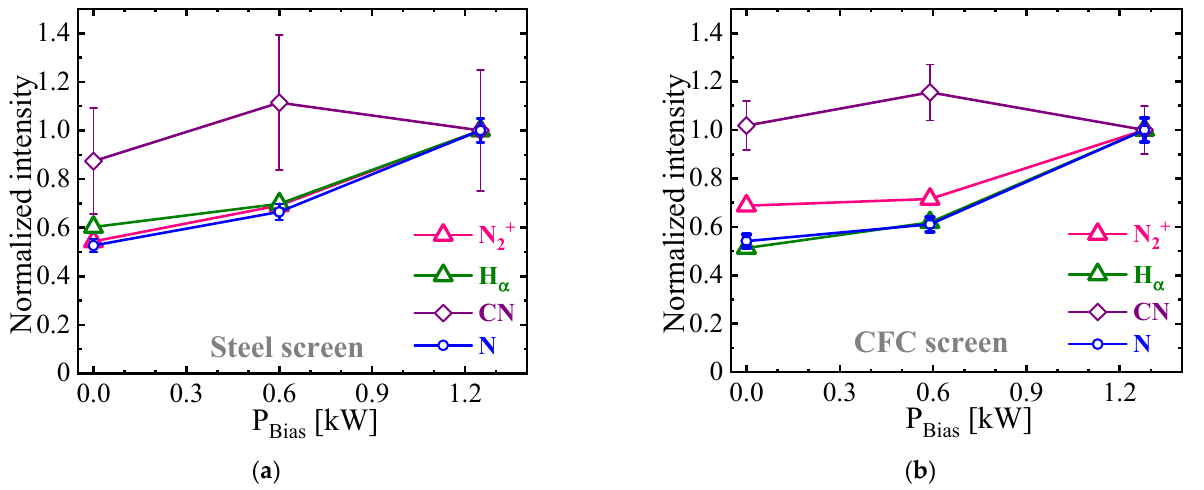
Figure 7. Peak intensities of CN, N 2+ , H, and N as functions of the bias power measured with low-resolution OES during ASPNC treatment using a steel AS ( Φ CH4 = 4 slh) ( a ) and a CFC-AS ( b ) at H 2 :N 2 = 1:1, p = 3 mbar, T = 460 °C, and Φ Total = 80 slh. The intensities are normalized to their respective values at a maximum bias power of 1.25 kW.